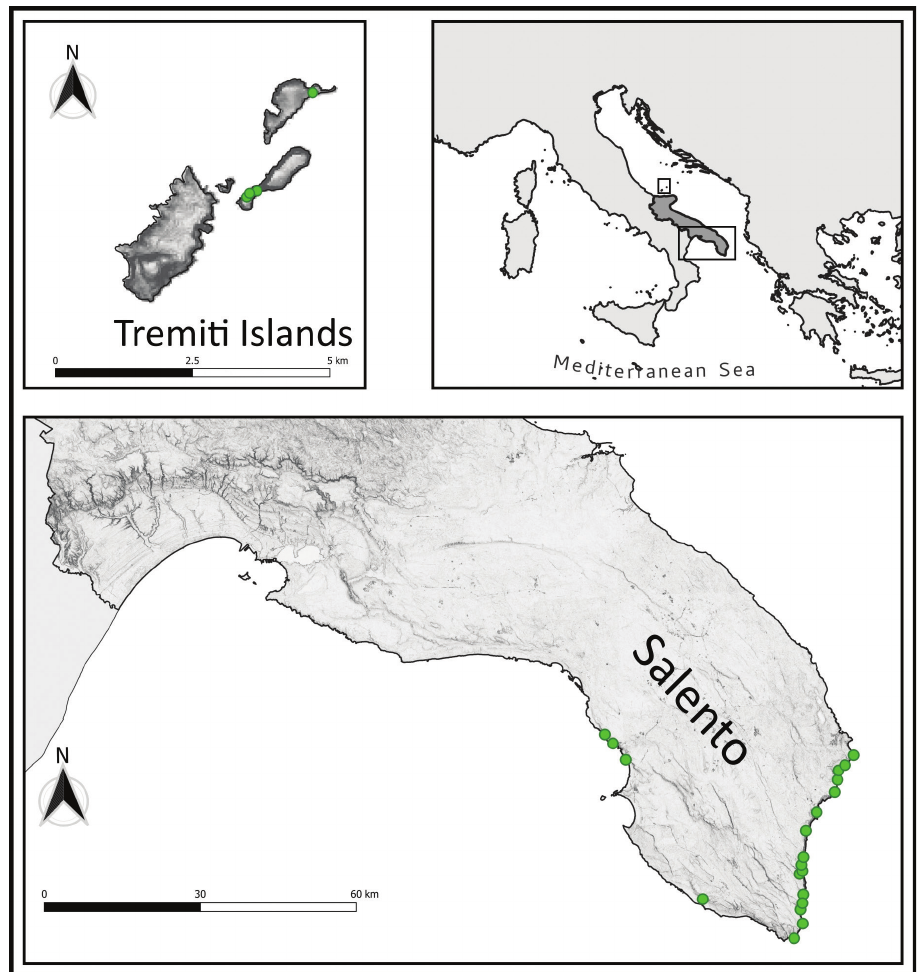
Figure 2. Geographic range and distribution map of Aurinia leucadea in